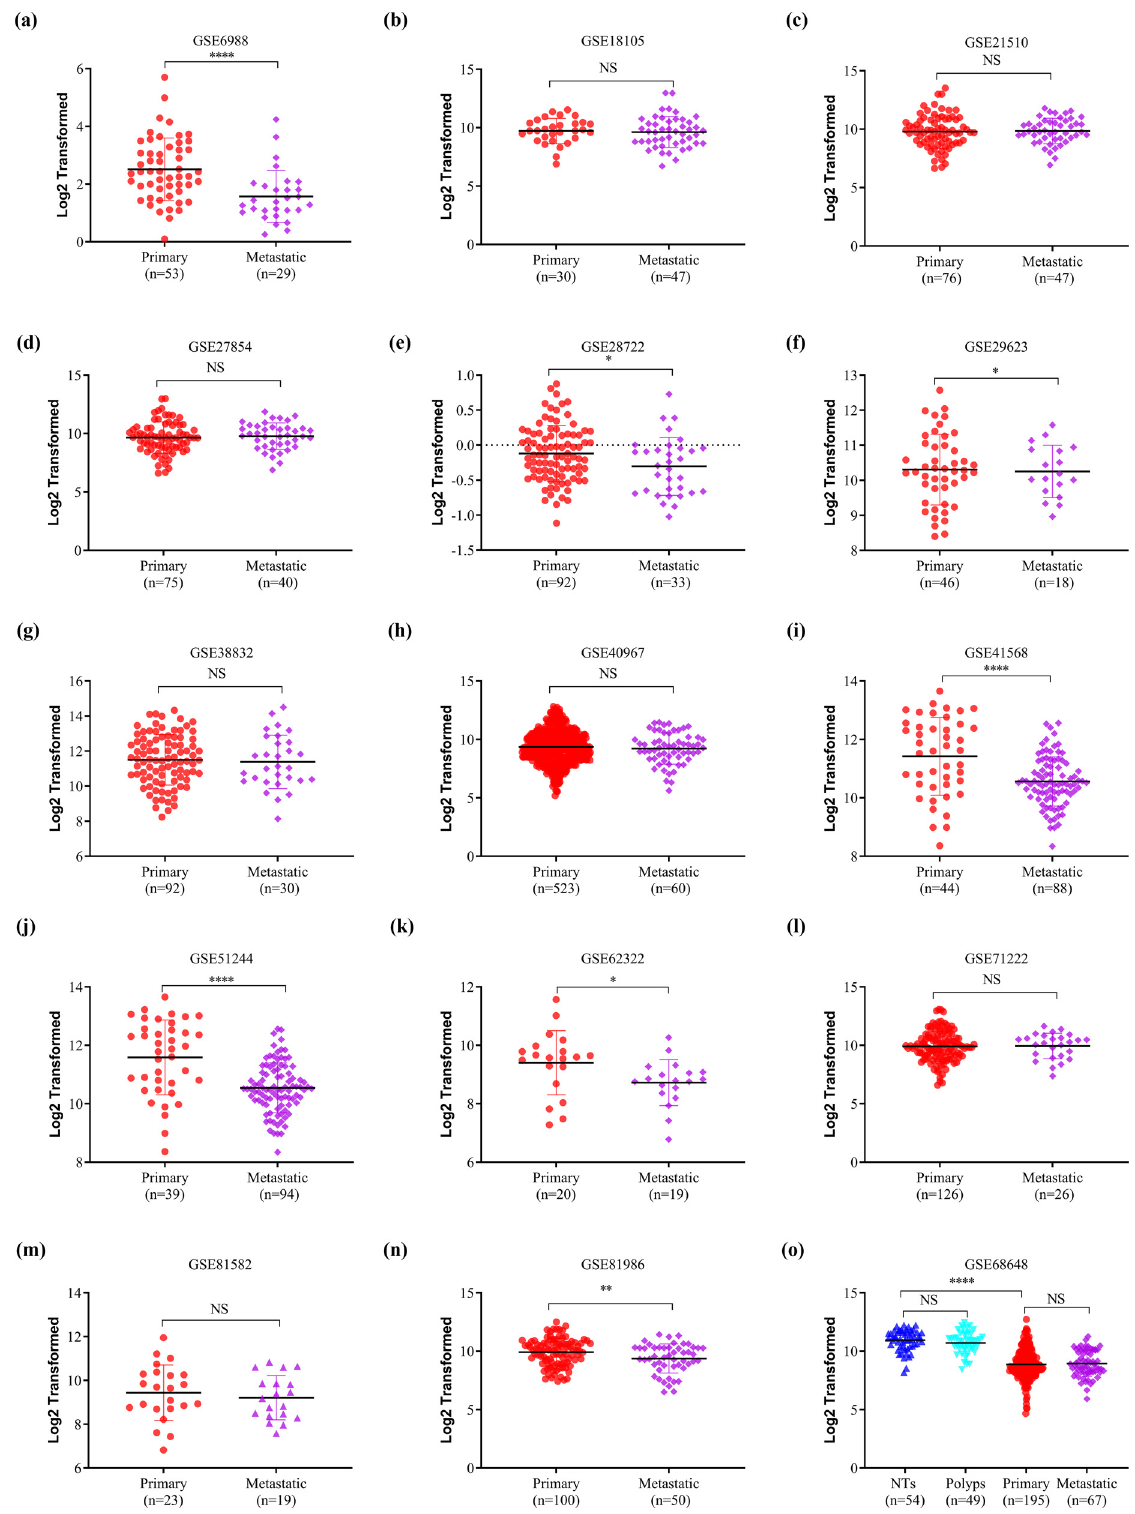
Figure 2: SELENBP1 expression is frequently downregulated in metastatic CRCs. The expression of SELENBP1 was compared between primary and metastatic CRCs in 15 datasets ( a – o ) , and among di ff erent stages of colorectal tumors in one dataset ( o ) . Abbreviation: NS, nonsigni fi cant. * p < 0.05; ** p < 0.01 ; **** p < 0.0001 vs the control